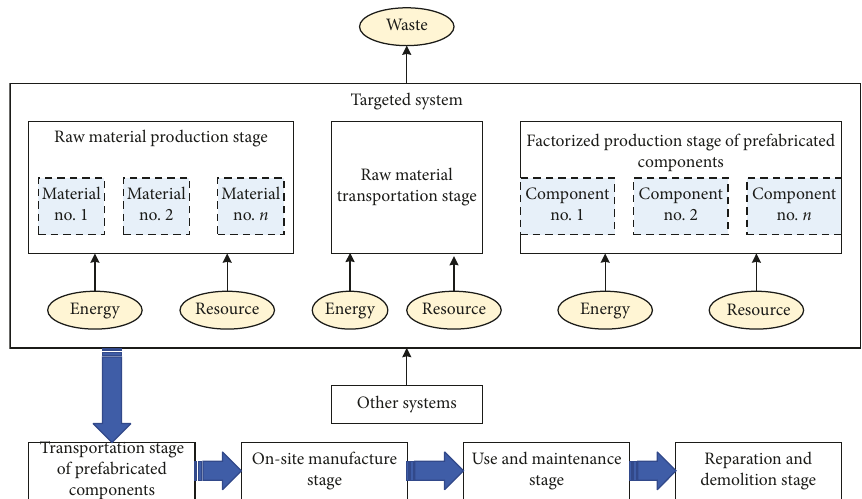
Figure 2: The targeted system of prefabricated components production.